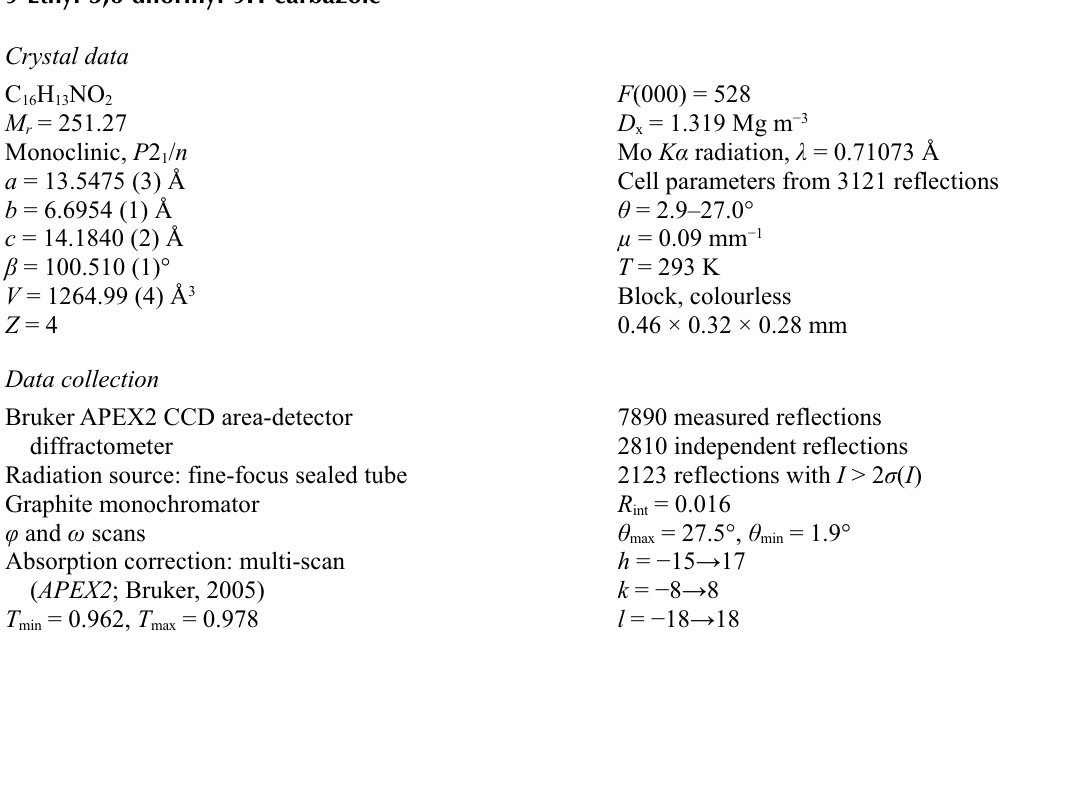
The molecular structure of title compound with labelling and 50% probability displacement ellipsoids.